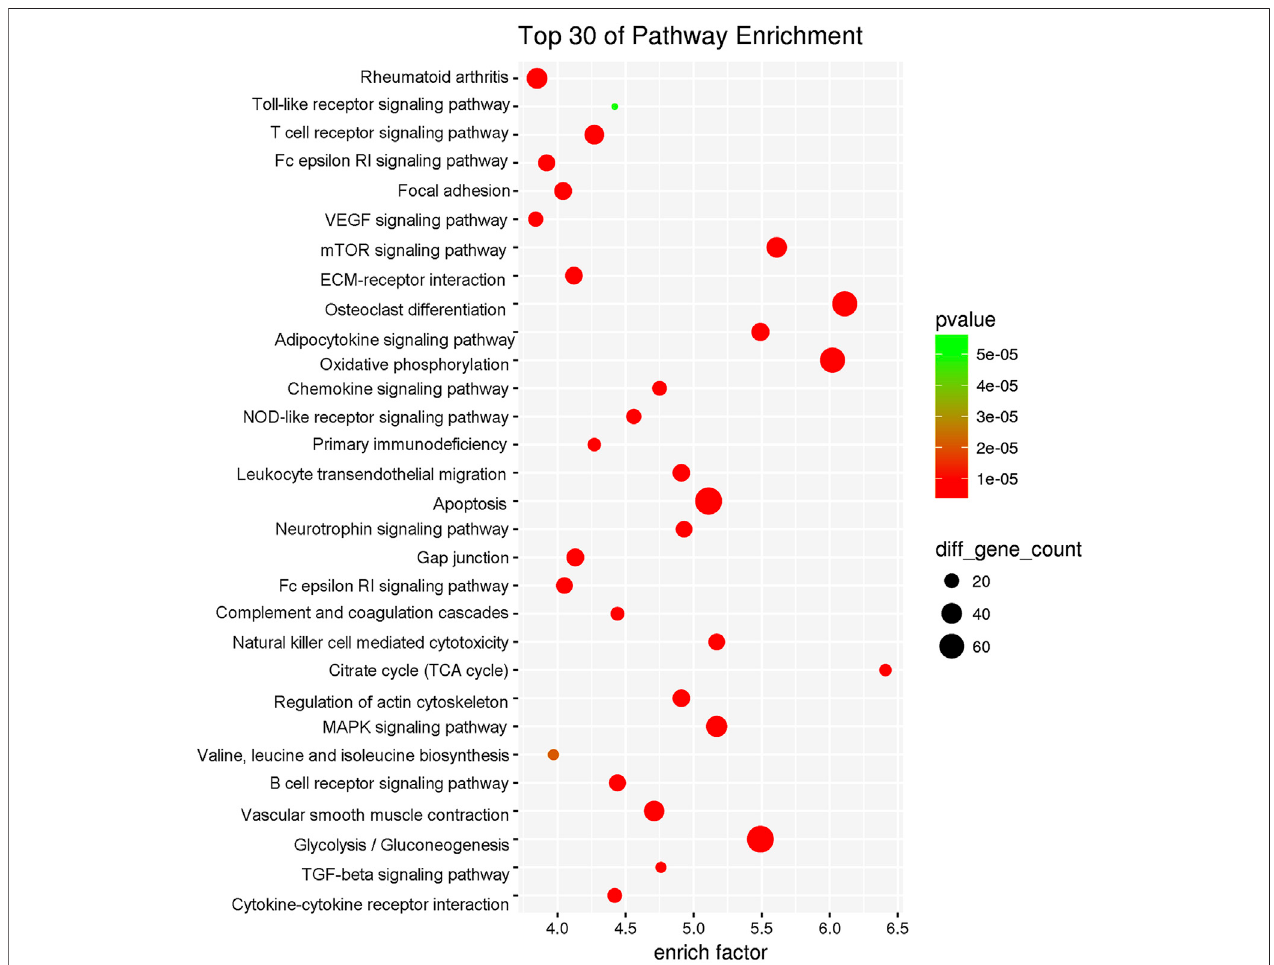
FIGURE 6 | Top 30 enriched pathways for the 135 hub genes in the effect of WBT against RA.